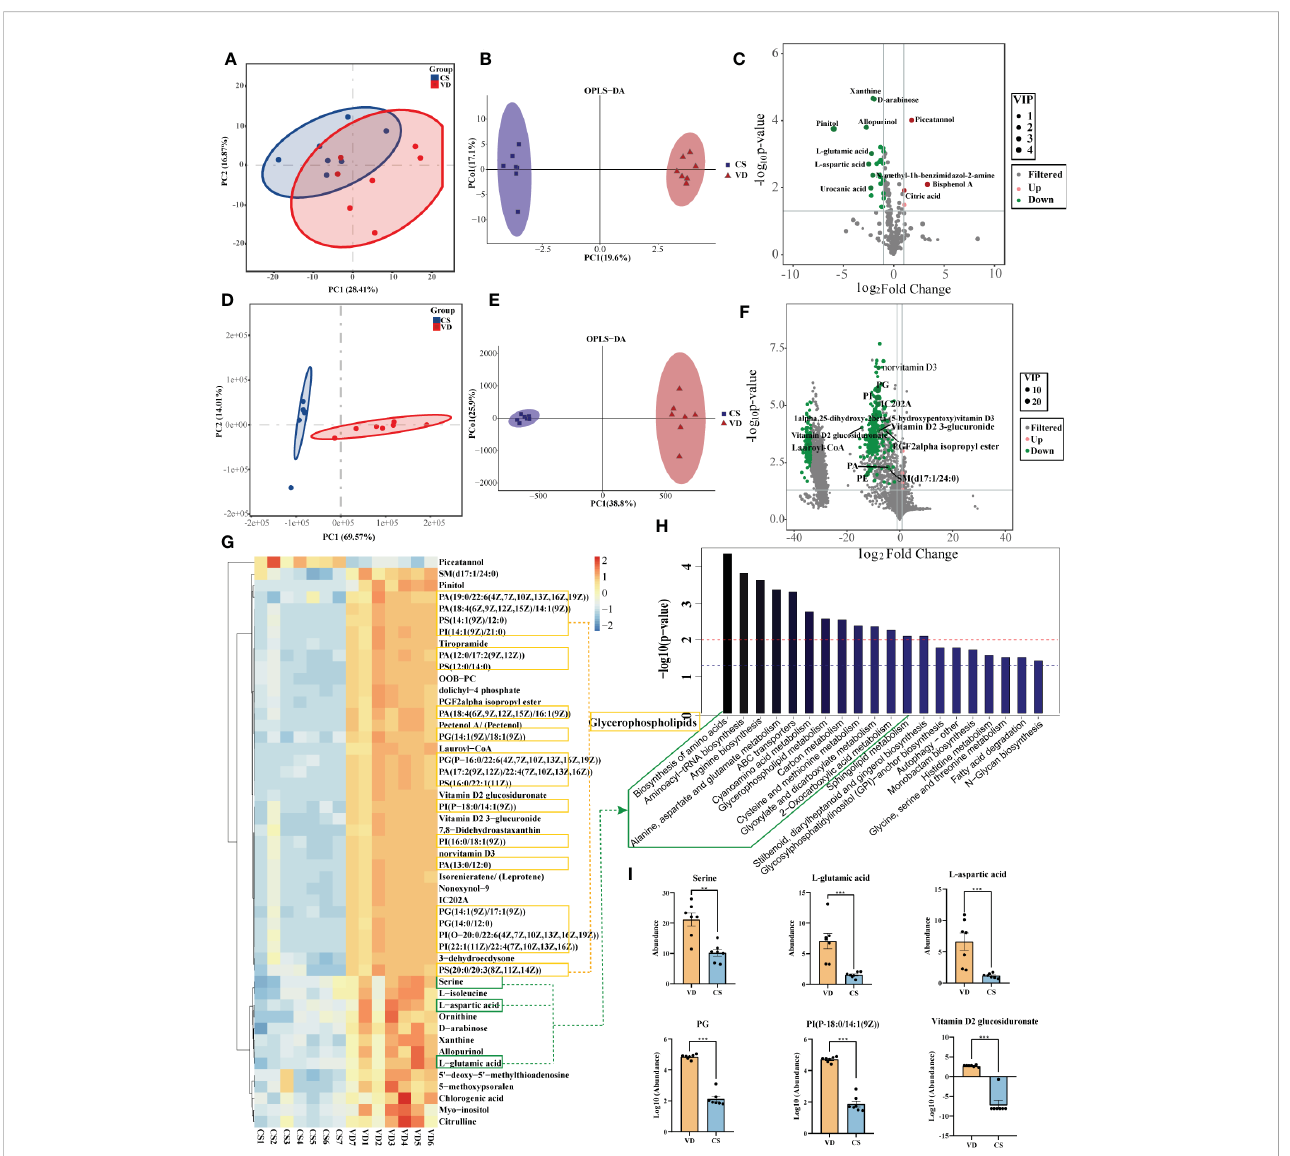
FIGURE 4 Metabolomics analysis for AF metabolites pro fi les in CS women compared with VD women. PCA (A) and OPLS-DA (B) score plots for differentiating the metabolites in each group by GC-MS/MS. (C) , Volcano plot showing the differentially accumulated metabolites in the CS AF (n = 7) and VD AF (n = 7) by GC-MS/MS. PCA (D) and OPLS-DA (E) score plots for differentiating the metabolites in each group by LC-MS/MS. (F) , Volcano plot showing the differentially accumulated metabolites in the CS AF and VD AF by LC-MS/MS. (G) , Hierarchical clustering analysis (HCA) of the metabolites that differed between the CS (n = 7) and VD (n = 7) subjects. (H) , Enriched KEGG pathways in CS AF group compared with VD AF group. (I) , Abundance comparisons of metabolites between CS AF group and VD AF group. Error bars represent SEM. **p < 0.01, ***p <